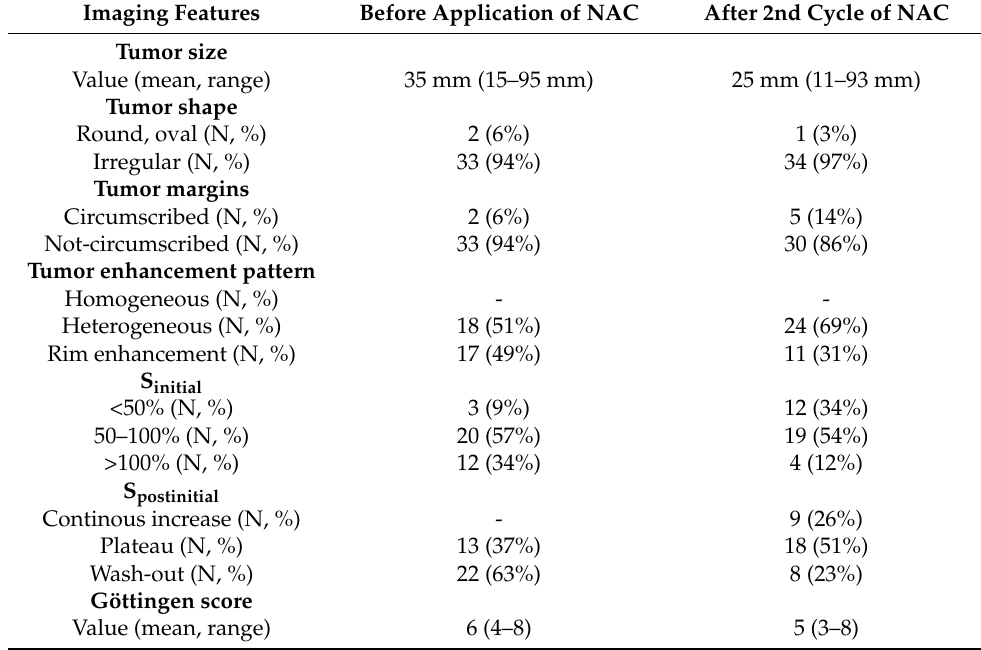
Table 3. Imaging features of breast cancer before and after the second cycle of NAC.